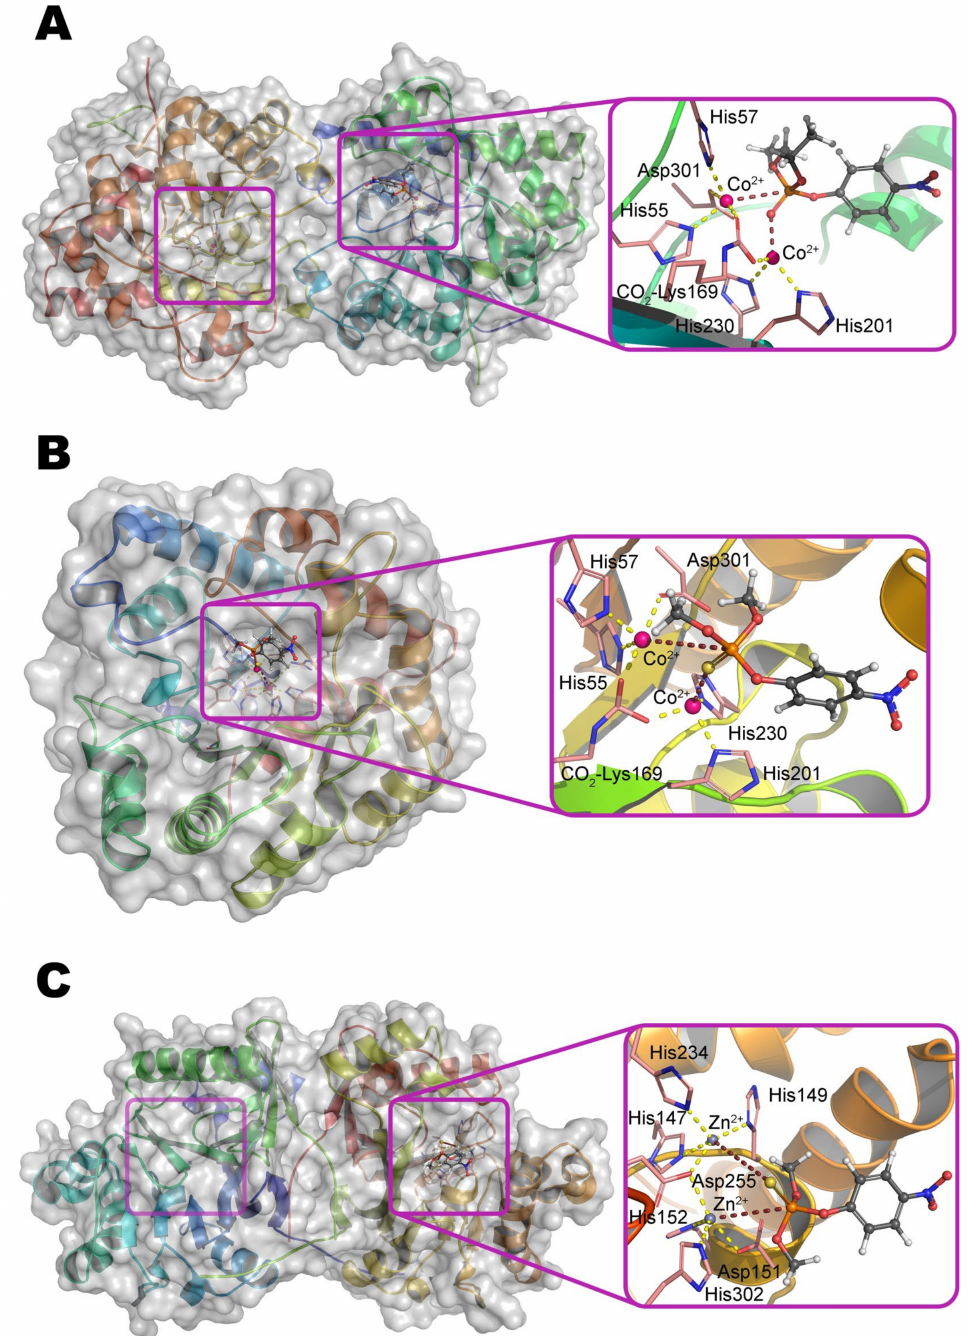
Figure 1. The structure of OPH dimer ( A ), OpdA monomer ( B ), and MPH dimer ( C ) according to X-ray diffraction data (PDB 1QW7, 2D2G, and 1P9E, respectively). The entrance to the active centers of the enzymes is framed, and their structures are shown in detail within insets. The binding of the substrate paraoxon ( A ) and methyl parathion ( B , C ) was determined by molecular docking using AutoDock Vina, as described previously [11] (Appendix A). The coordination bonds of metal ions with amino acid residues in active centers, as well as with labile groups of the substrate are shown by a dashed